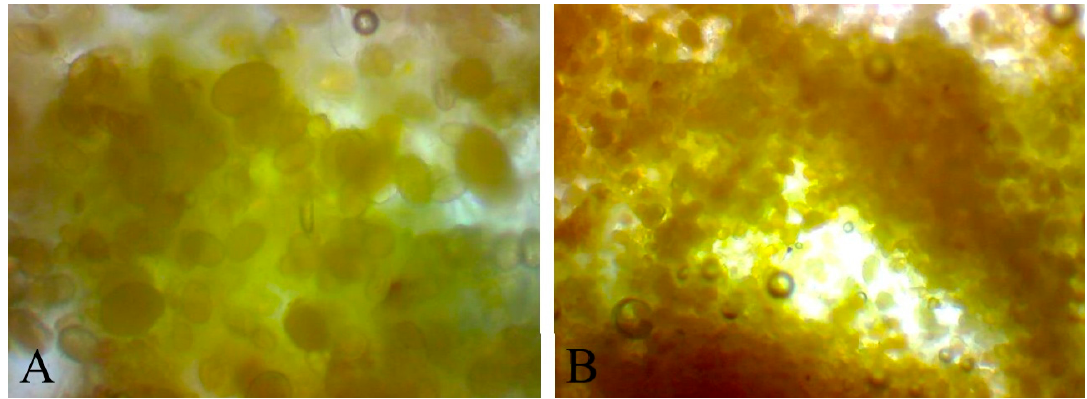
Figure 4. Microscopic images of beebread caviar after 3 days of storage: ( A )—4× magnification, ( B )—10× magnification .